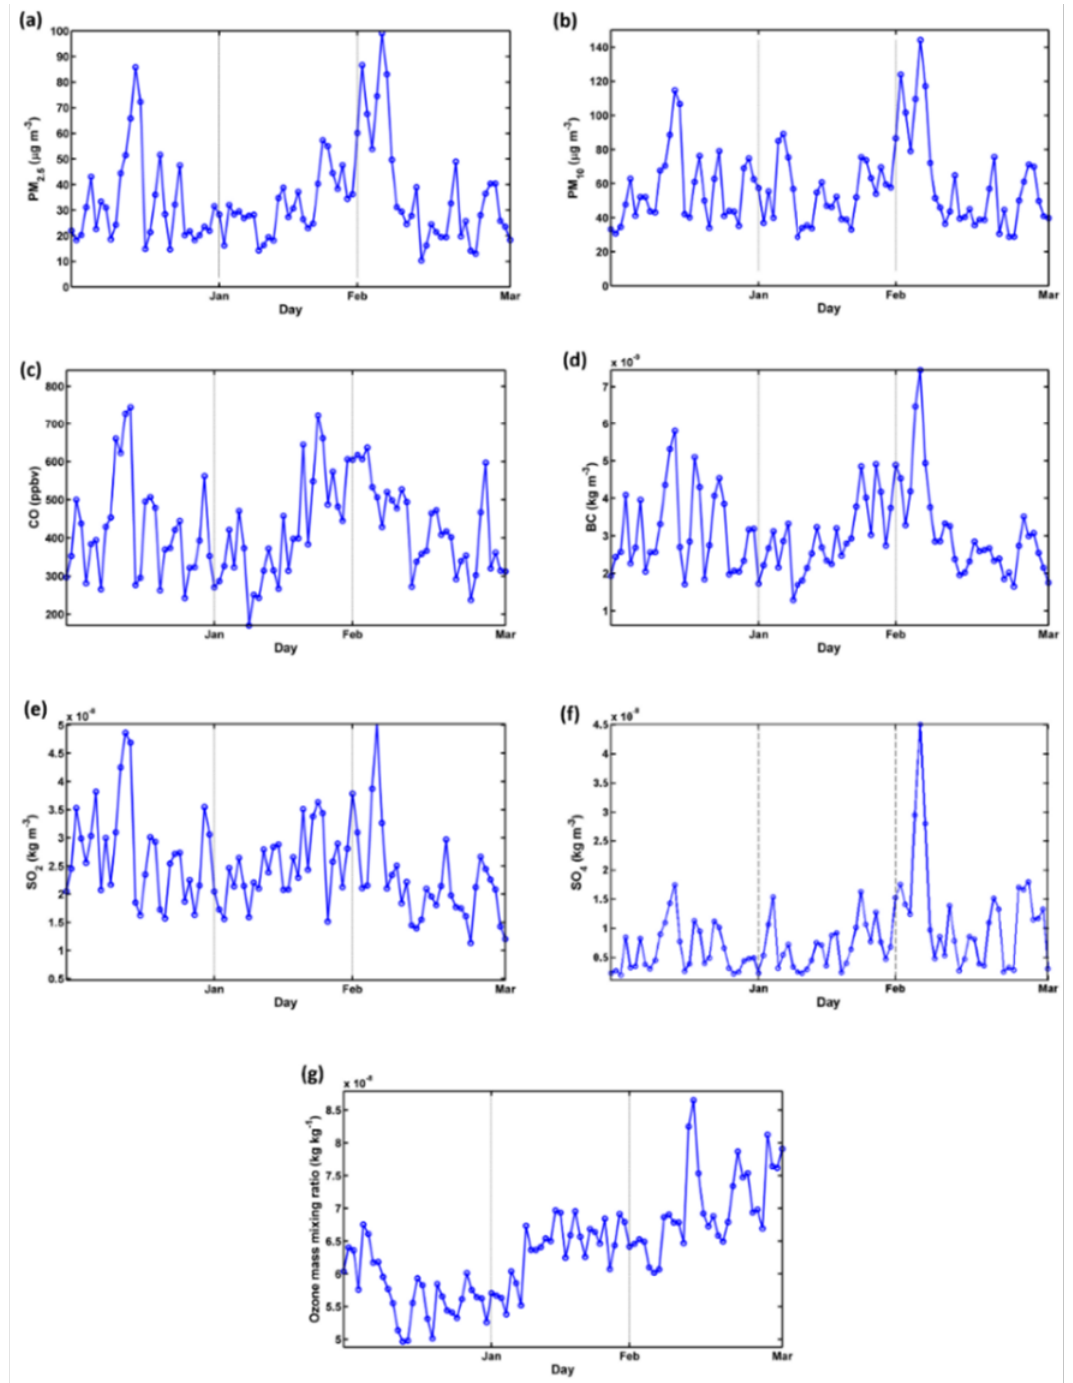
Figure 3. Diurnal distribution of particulate matter (PM) and other pollutants from January to March for 2019. ( a ) PM 2.5 , ( b ) PM 10 , ( c ) CO, ( d ) BC, ( e ) SO 2 , ( f ) SO 4 , and ( g ) ozone mass mixing ratio. Figure S3 depicts the diurnal variation in PM concentrations during this time period.